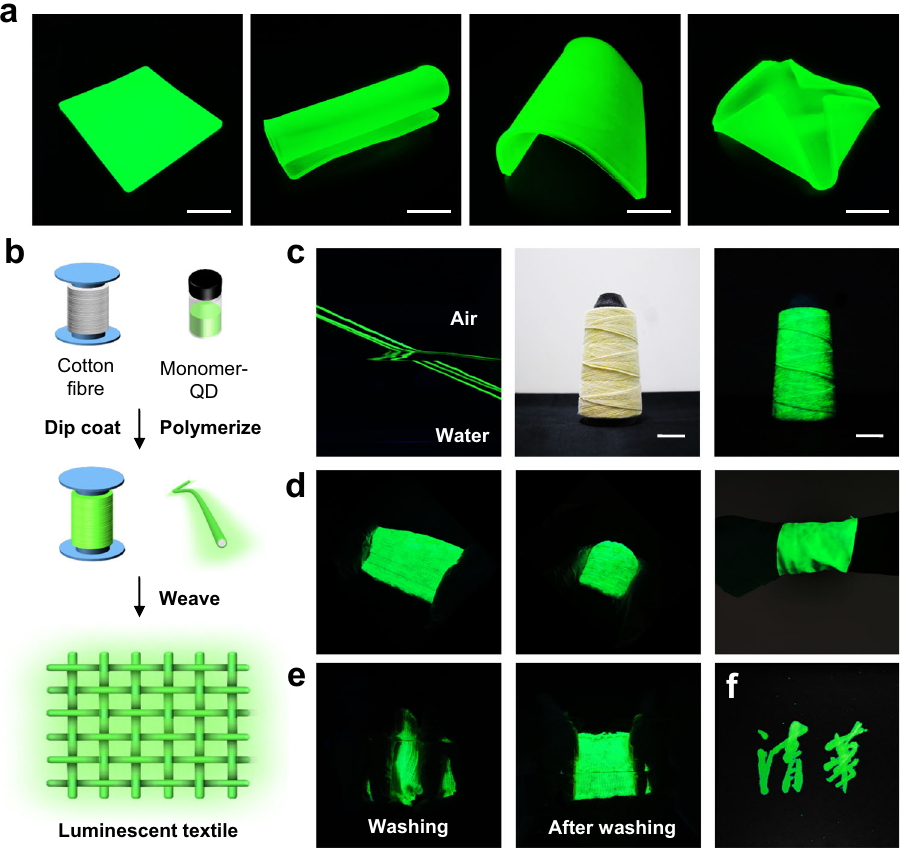
Fig. 8 Potential applications of TFE-HF-QD 1.0 . a A large dimensional TFE-HF-QD 1.0 fi lm was prepared. It could emit light under different deformations. Scale bar, 5 cm. b Schematic illustration for the preparation of underwater luminescent textile. c Luminescent fi bre could keep stable both in air and water (left). Photographs of TFE-HF-QD 1.0 cotton fi bre on a spool (middle and right). Scale bar, 2.5 cm. d A large dimension luminescent cotton fabric (left and middle). It could be used as a wristband (right). e Washing process of the luminescent textile. f A hand-writing luminescent